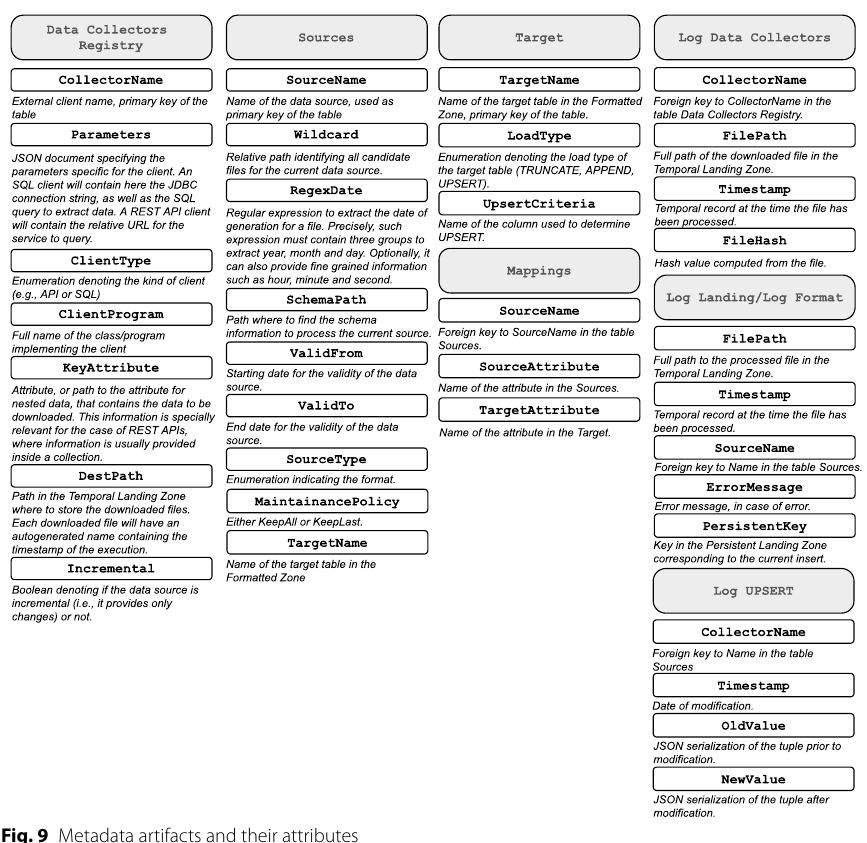
Fig. 9 Metadata artifacts and their